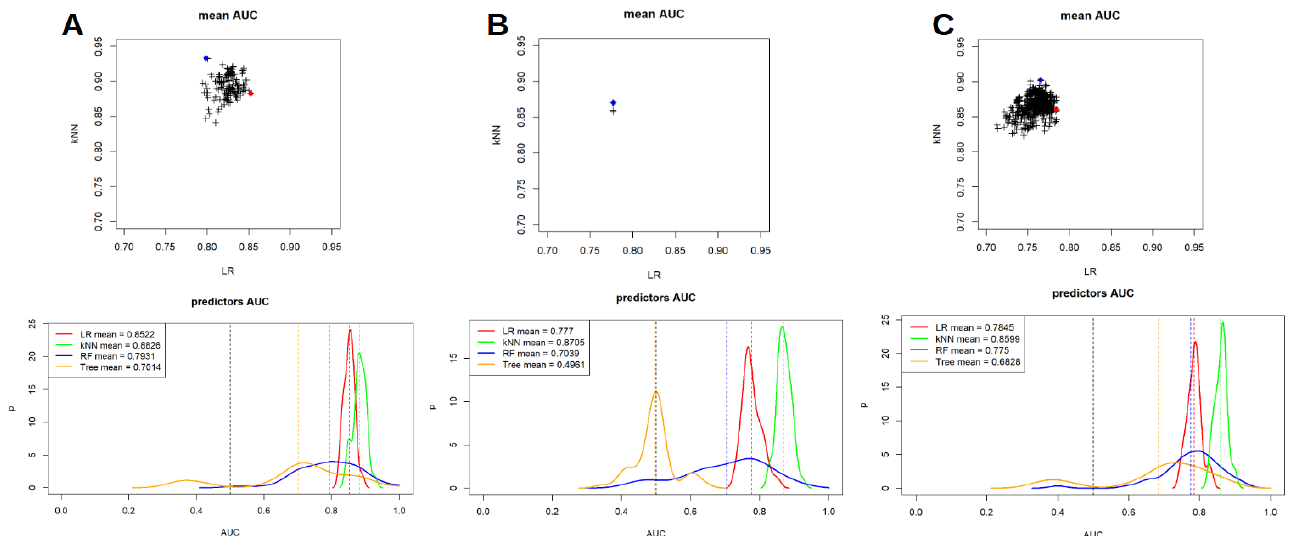
Figure 3. Comparison between LR, kNN, random forest and tree models performances for scanner 1 ( A ), scanner 2 ( B ) and both the scanner considered together ( C ).